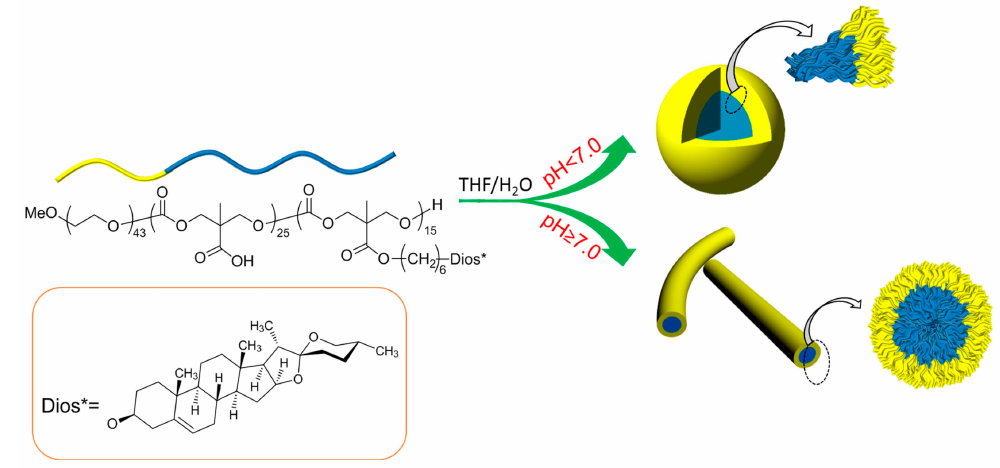
Figure 4. Self-assembly behaviour of mPEG 43 -PMCC 25 -P(MCC-DHO) 1 as a function of pH in tetrahy- drofuran/water. Reprinted with permission from Guo et al., Nanomaterials , 2017 , 7 , 169